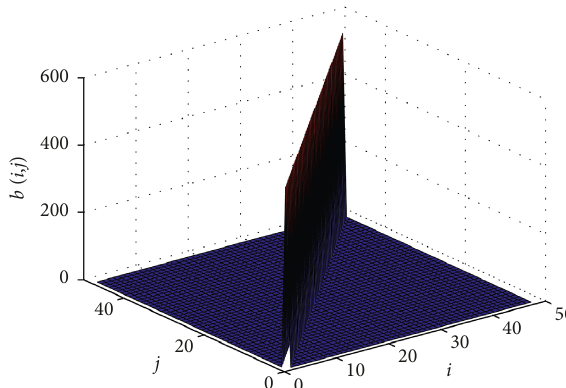
Figure 13: Control gains b